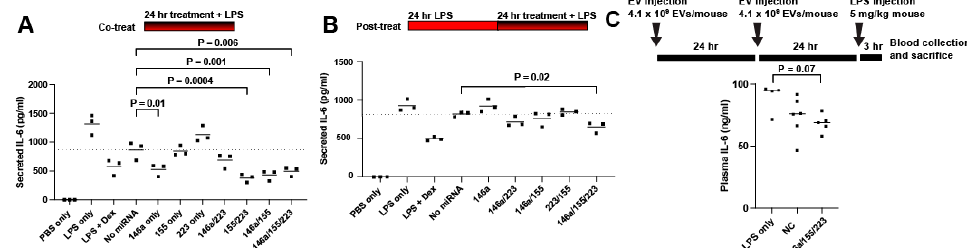
Figure 3. Screening of miRNA for anti-inflammatory combination. ( A ) Secreted IL-6 in response to LPS in a co-treatment regime. ( B ) Secreted IL-6 in response to LPS in a post-treatment regime. ( C ) IL-6 plasma levels in endotoxemic mice. Results were analyzed via one-way ANOVA. 2.3. Delivery of miRNAs 146a/155/223 Has Variable Anti-Inflammatory Effects Aside from Reducing IL-6 Secretion